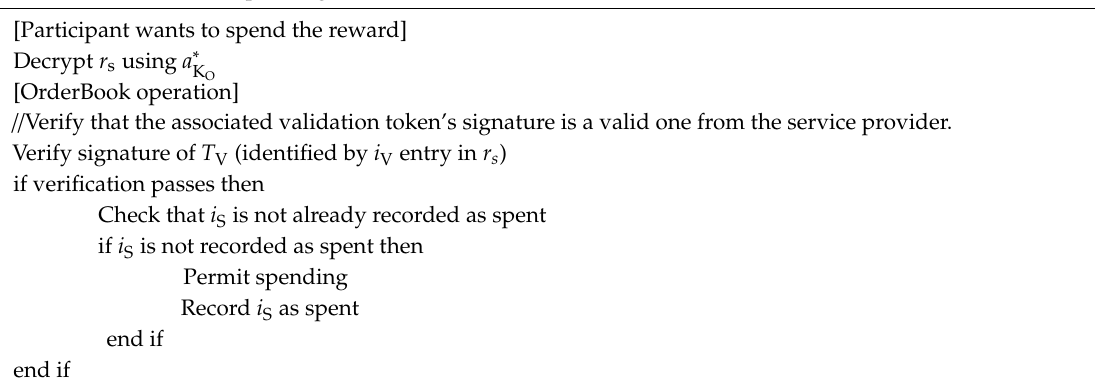
Algorithm 2 : Reward